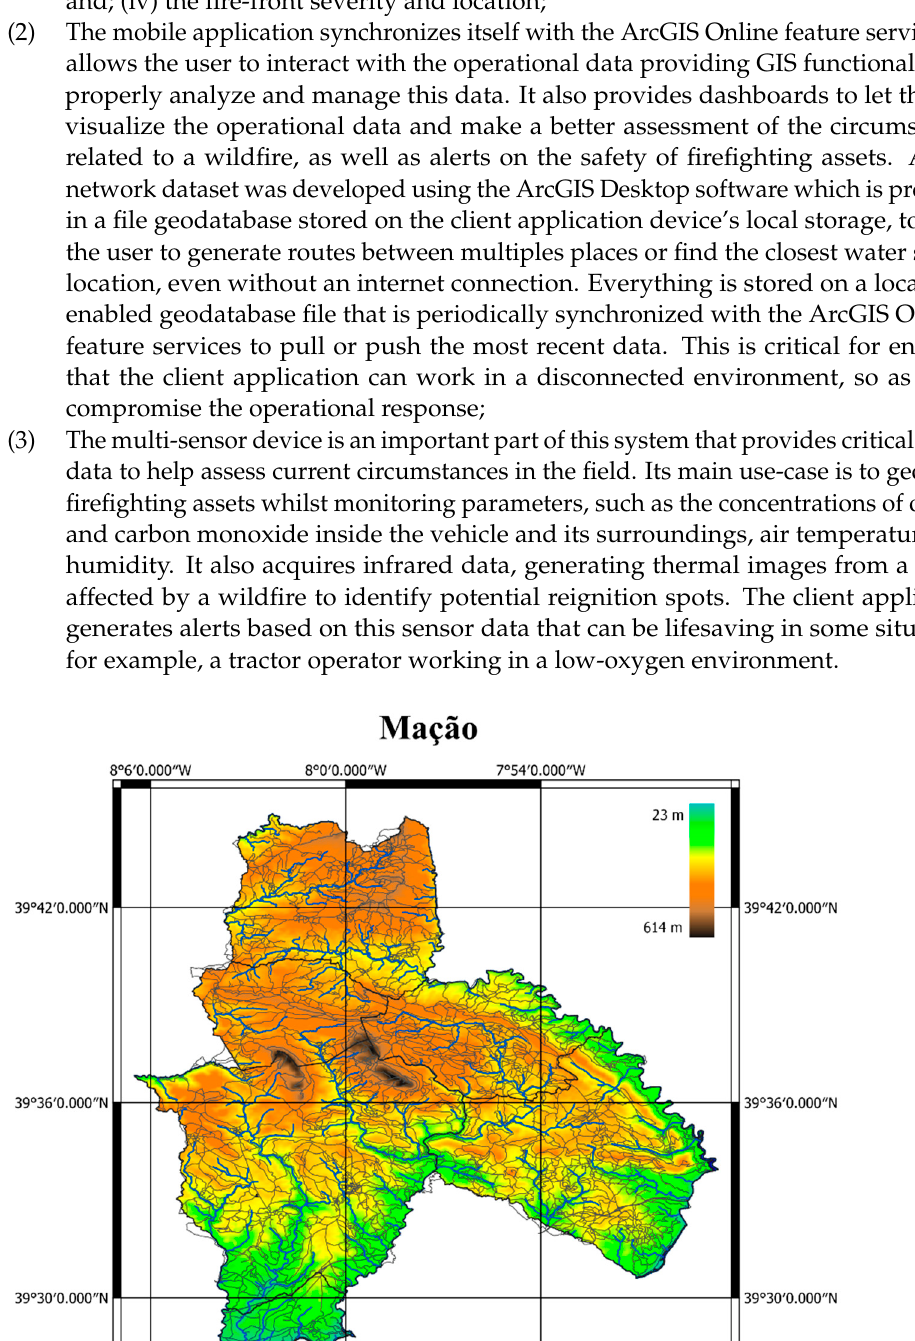
Figure 2. The architecture of the proposed decision support system.